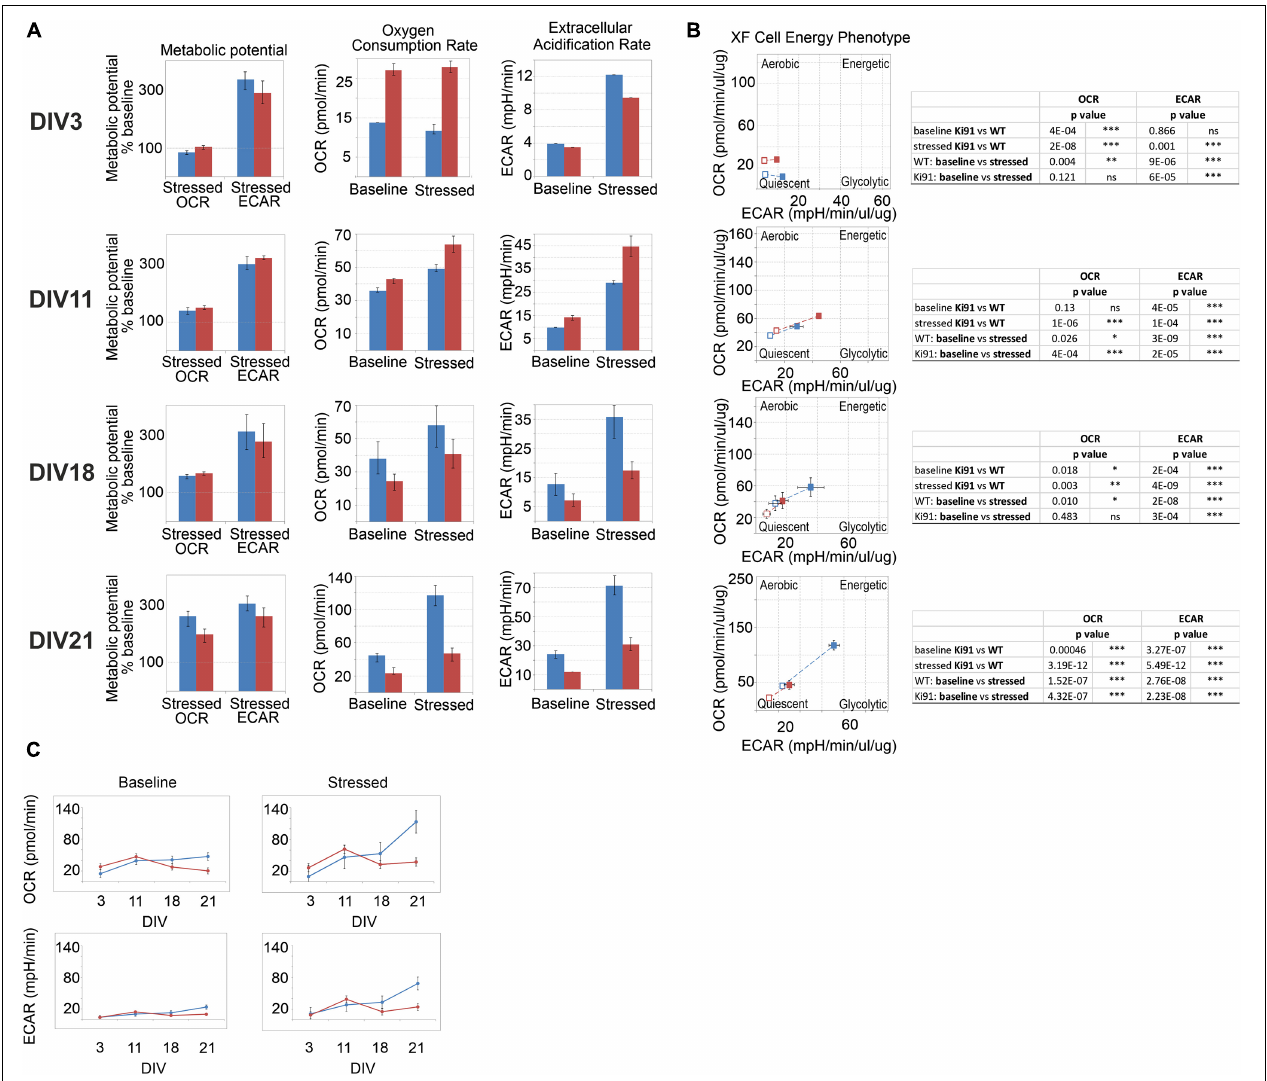
FIGURE 7 | The energy metabolism measured by Seahorse XFp Cell Energy Phenotype Test is impaired in the P5 cerebellar neurons of Ki91 SCA3/MJD. The assays were performed with cerebellar neurons at DIV3, 11, 18, and 21. The rate of mitochondrial respiration (OCR, oxygen consumption rate) and glycolysis (ECAR, extracellular acidification rate) were measured under baseline and stressed conditions, which were evoked by specific stressors: 1 µ M of oligomycin and 1 µ M of FCCP. The bioenergetic parameters are shown for OCR (pmol/min), ECAR (mpH/min), and metabolic potential [(stressed OCR or ECAR/baseline OCR or ECAR) × 100%)] in (A) . In DIV3 and DIV11, OCR in neurons is elevated in Ki91 compared to WT ( p < 0.001; two-sample t -test), but in later stages (DIV21), both OCR and ECAR are severely decreased in Ki91 neurons ( p < 0.001; two-sample t -test) under both baseline and stressed conditions (A) . WT cerebellar